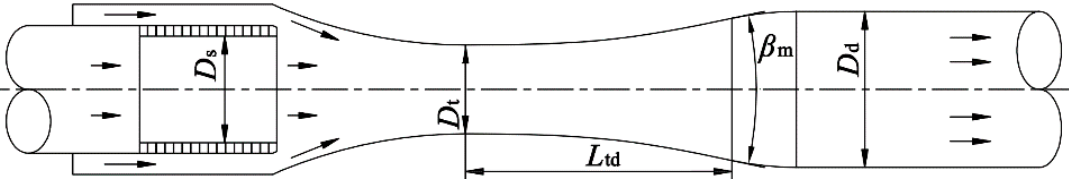
Figure 2. Streamlined annular jet pump (SAJP).